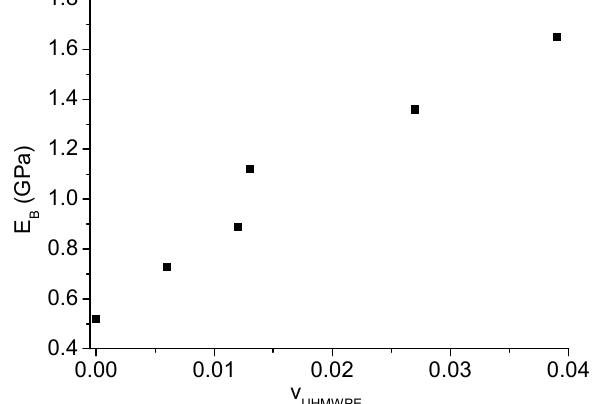
Figure 9. Equivalent bending modulus of reinforced plates as a function of UHMWPE fiber volume fraction.